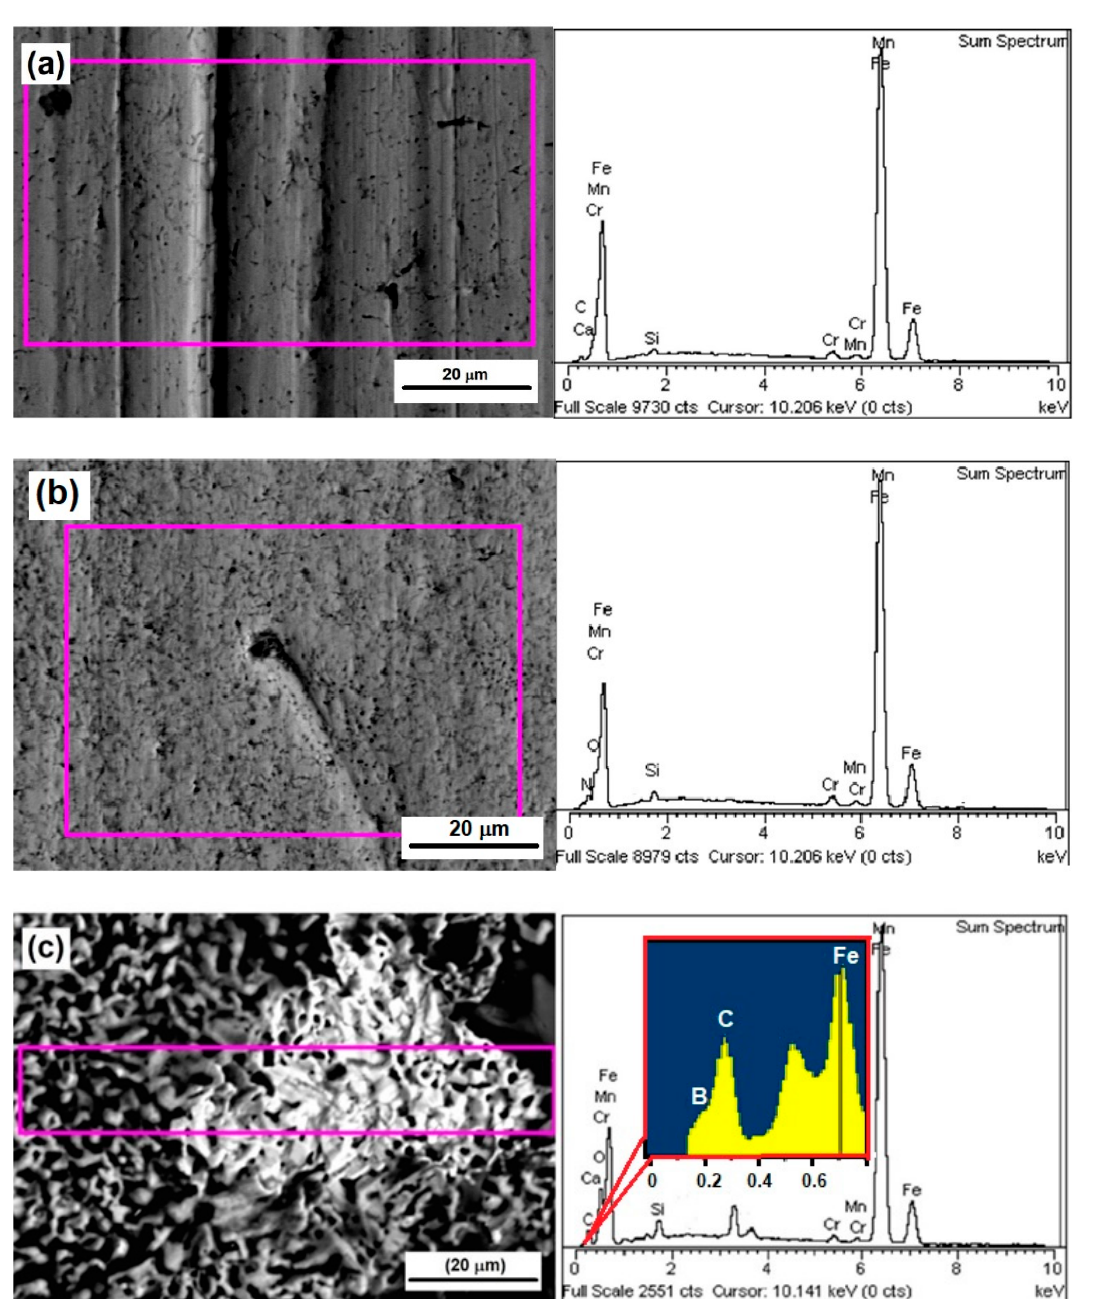
Figure 5. EDS analysis of the wear tracks of the samples exposed to ( a ) carburizing, ( b ) nitriding, and ( c ) boriding processes.